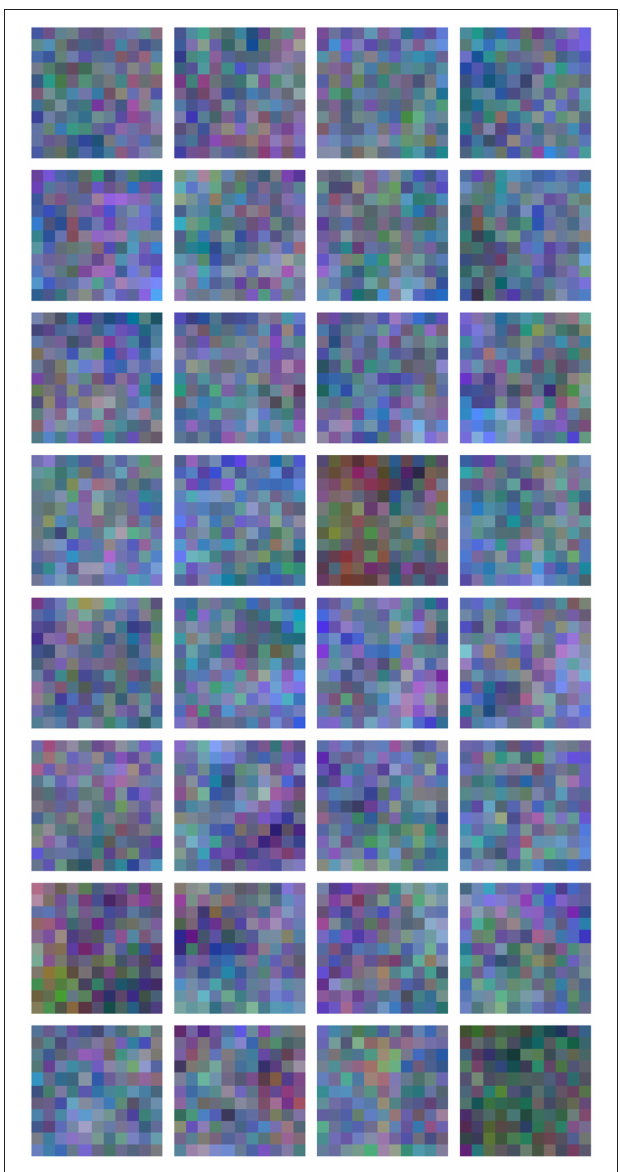
FIGURE 6 | Visualization of filter weights in the first convolutional layer of a leaf counting